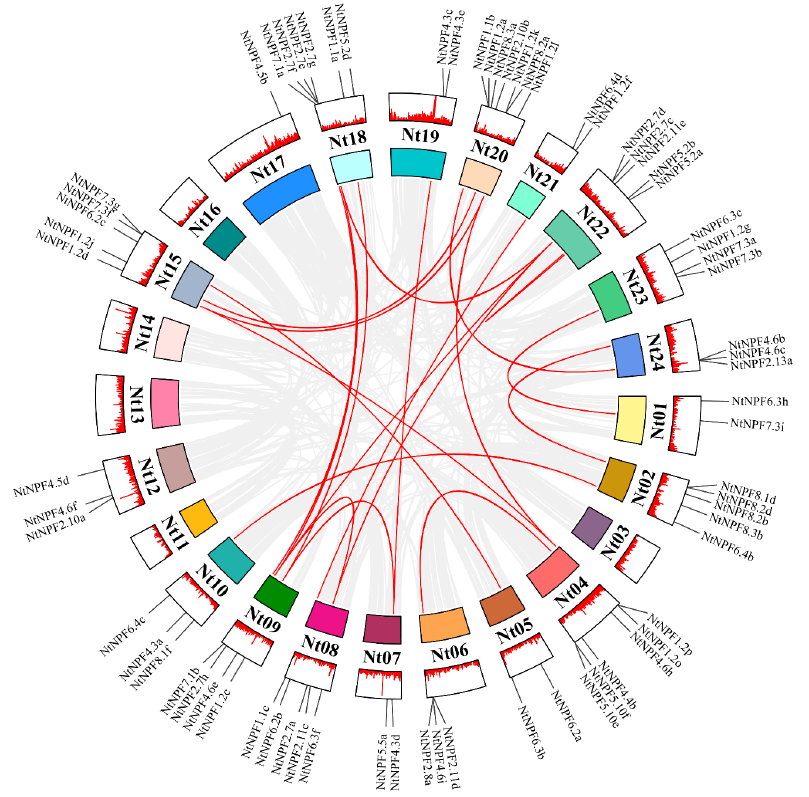
Figure 4. Chromosome distribution and collinearity of the NtNPF genes in Nicotiana tabacum . The gray lines in the background indicate all the syntenic blocks in the N. tabacum genome, and the red lines indicate syntenic NPF gene pairs.